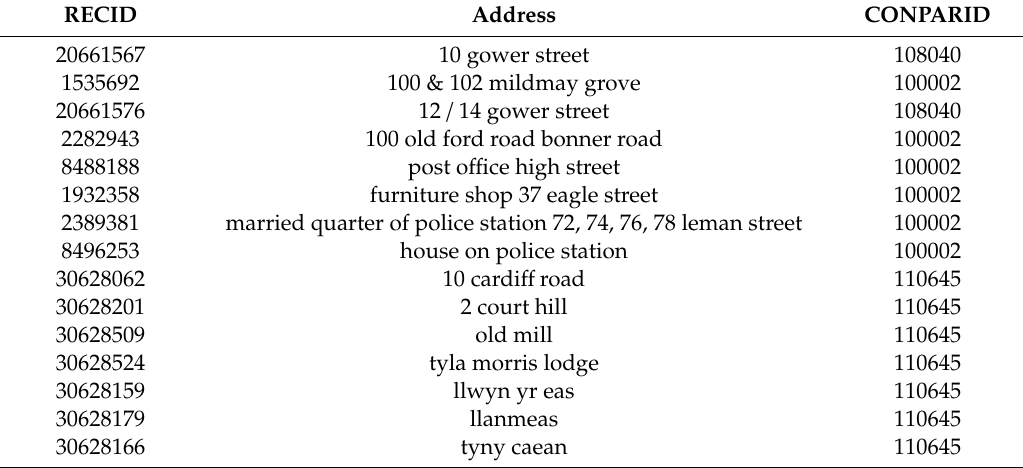
Table 1. An illustrative sample of addresses in England and Wales as recorded in the 1901 Census. RECID